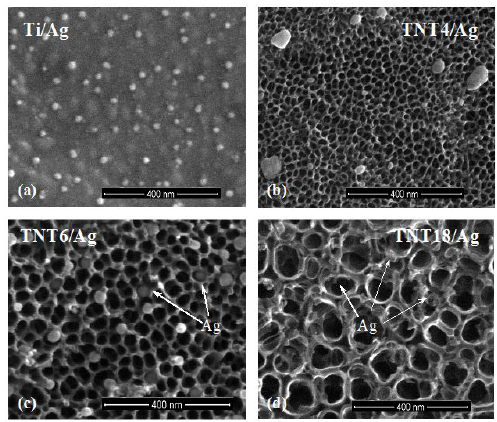
Figure 1. Scanning electron microscopy images of silver nanograins deposited on the surface of Ti ( a ); TNT4 ( b ); TNT6 ( c ); and TNT18 ( d ), samples, respectively (CVD, precursor: Ag(OOCC 2 F 5 ), deposition temperature ( T D ) = 280 ◦ C, reactor pressure ( p ) = 3 mbar, deposition time ( t ) = 30 min, mass of the precursor ( m ) = 5 mg, substrate: Titanium foil (99.6% Ti, 0.20 mm thick,